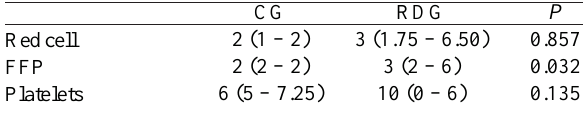
Table 3. Transfusion of red blood cells, fresh frozen plasma and platelets units during